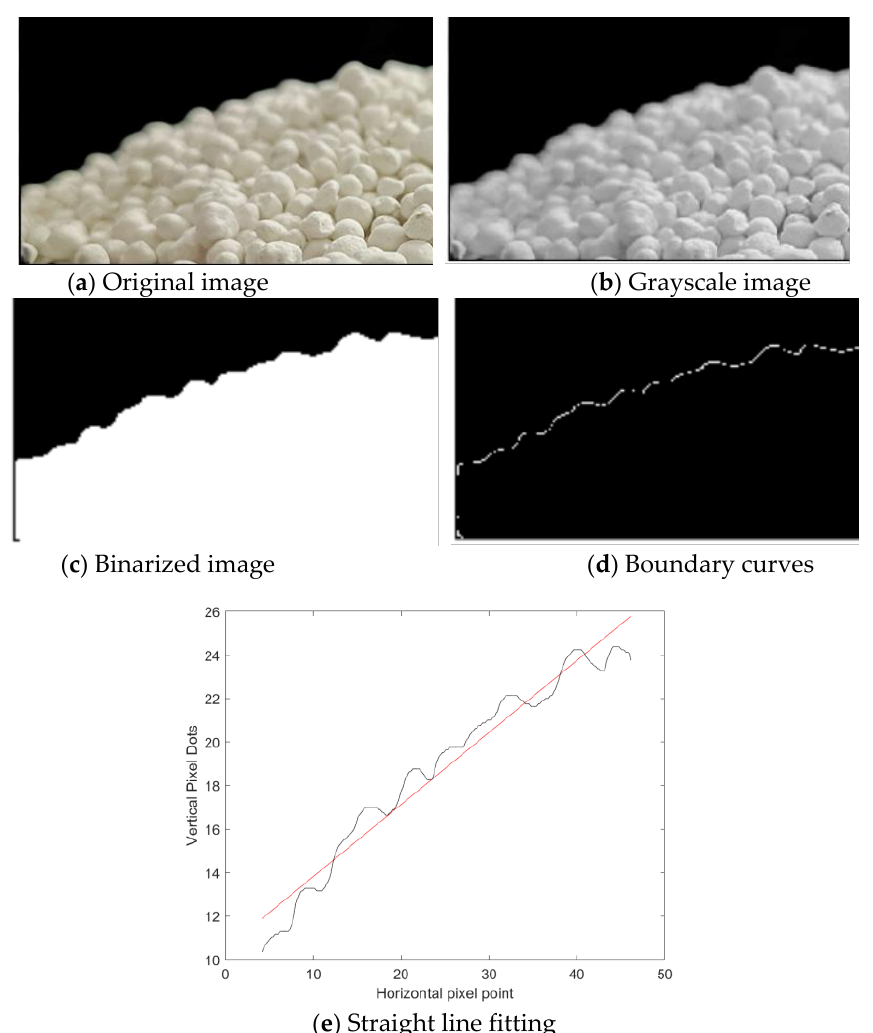
Figure 2. Measurement of actual angle of repose ( a – e ).